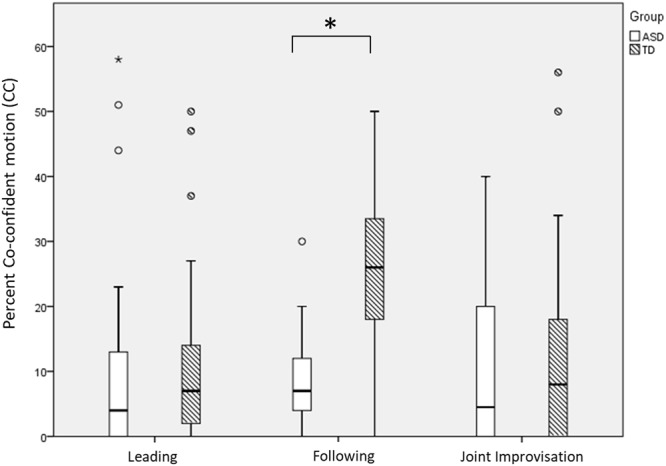
Percent co-confident (CC) motion by game round and group. Participants with ASD had lower CC rates than TD participants (main effect of Group), and this was most pronounced in the Following round (interaction effect of Group and Round). Large asterisks represent p < 0.05 group differences. Boxplots: the solid line represents the median of the distribution; the outlines of the box represent the interquartile range, or 25th–75th percentiles; the whiskers represent the upper and lower quartiles, excluding outliers; small points and asterisks represent outliers and extreme outliers, respectively.